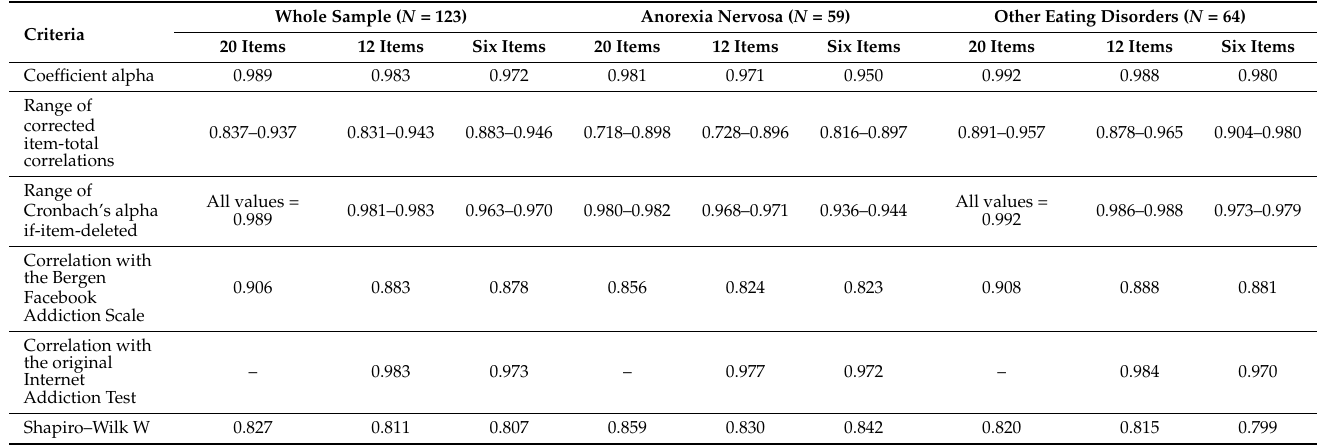
Table 5. Internal consistency, criterion validity, and normality tests of the Internet Addiction Test (20 items, 12 items, and six items) in EDs samples.